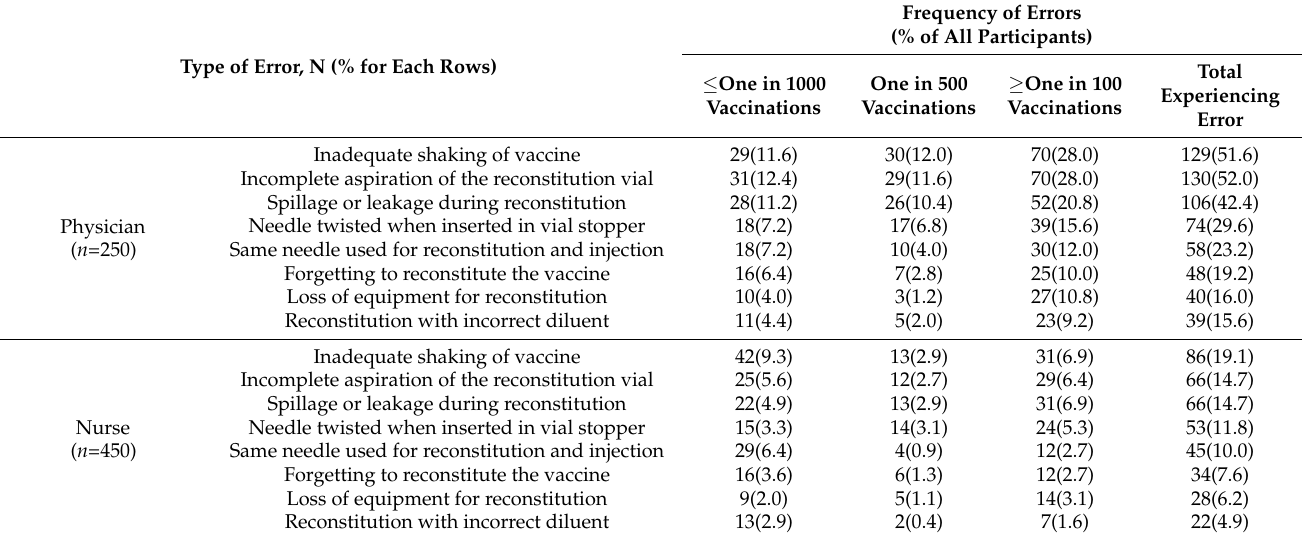
Table 3. Types of error and reported frequency of each error occurring.